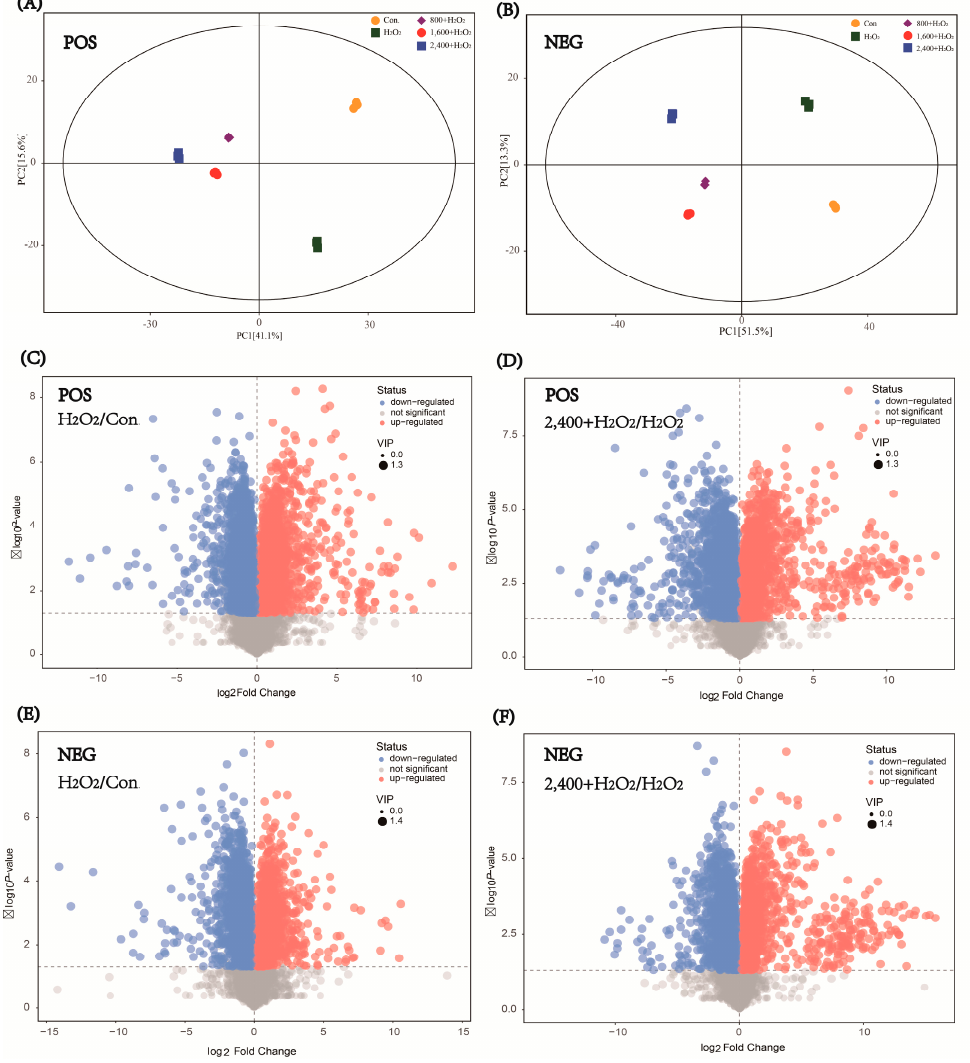
Figure 5. H 2 O 2 and chrysanthemum extract induced significant metabolic changes. L − O2 cell treated with H 2 O 2 and chrysanthemum extract were lysed for a metabonomic analysis. According to the profile of metabolites, principal component analysis was performed ( A , B ). The volcano plot was generated according to the differences in metabolite abundance ( C – F ). POS: data achieved from positive ion mode of mass spectrum; NEG: data achieved from negative ion mode of mass spectrum. Con.: control; H 2 O 2 : 7 mM H 2 O 2 ; 2400 + H 2 O 2 : 2400 μ g/mL chrysanthemum extract and 7 mM H 2 O 2 .